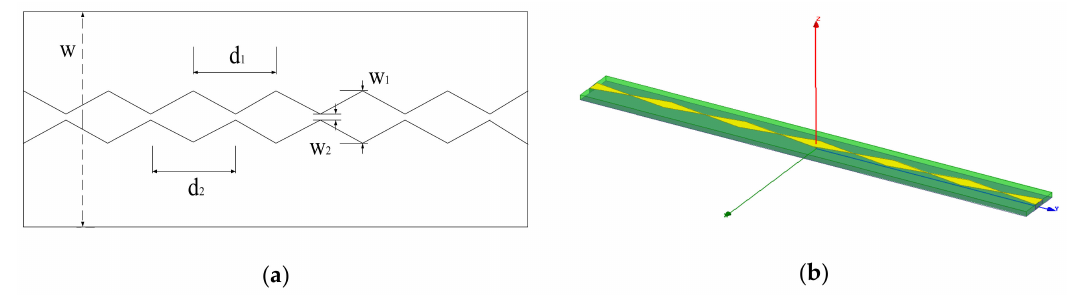
Figure 1. ( a ) Perspective picture of the microstrip band stop filter based on asymptote; ( b ) simulation results of the microstrip band stop filter based on asymptote.